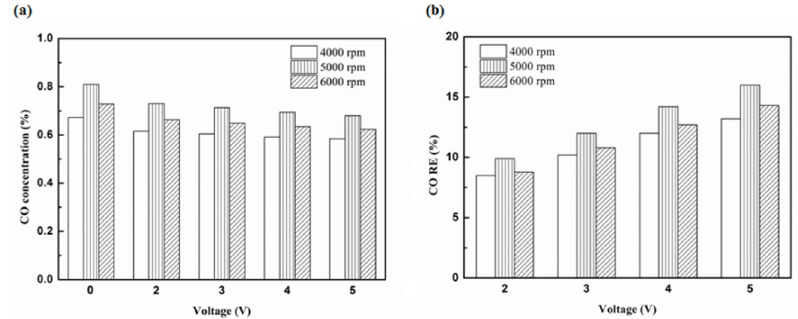
Figure 15. The CO ( a ) emission values and ( b ) RE using iridium alloy in the rear of the exhaust pipe.